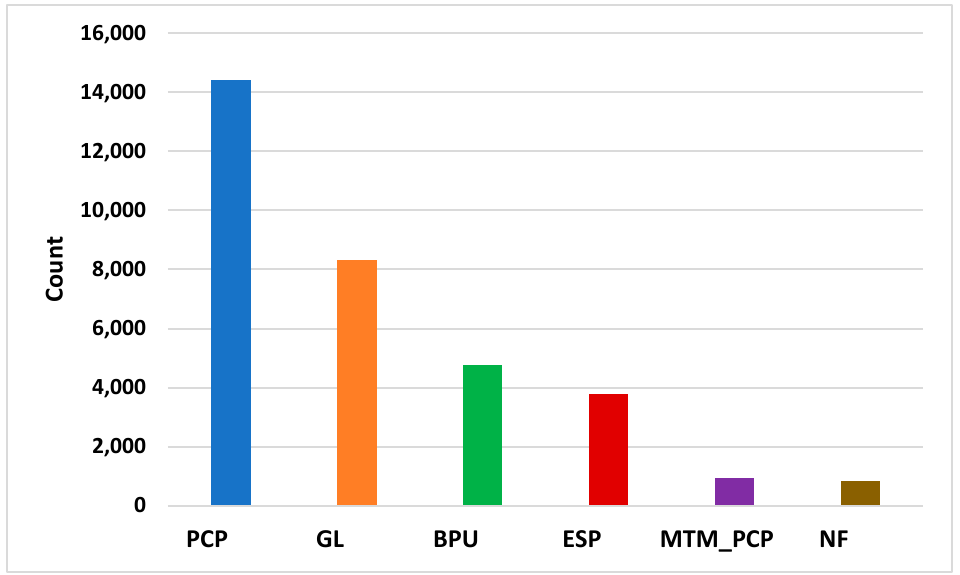
Figure 2. AL distribution in the dataset.